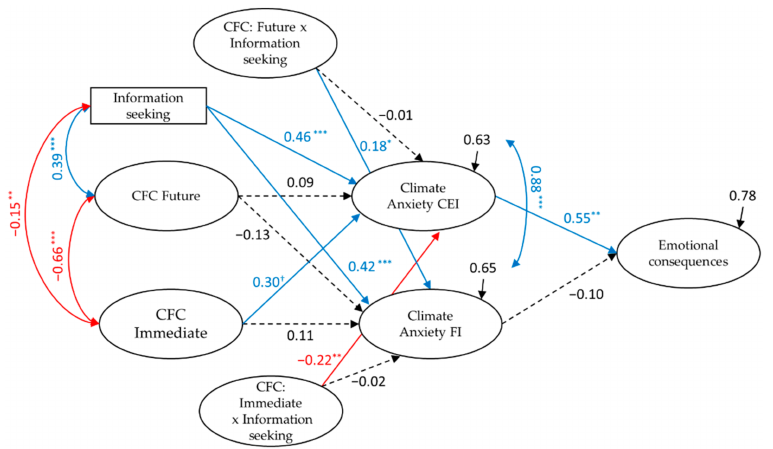
Figure 3. Standardized Estimates from Structural Equation Model with interactions. Latent factor indicators not shown for clarity. Blue arrows represent positive relationships. Red arrows represent negative relationships. Black dashed arrows represent non-significant relationships. † p < 0.10. * p < 0.05. ** p < 0.01. *** p <